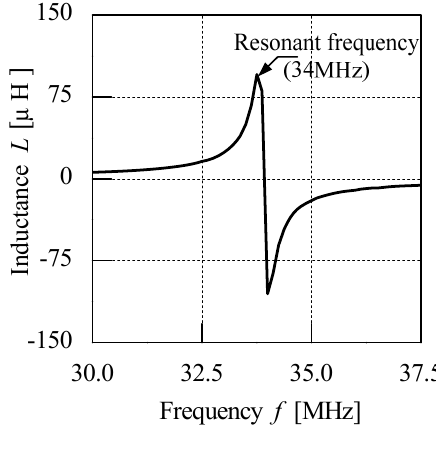
Figure 6. Inductance characteristics for the air